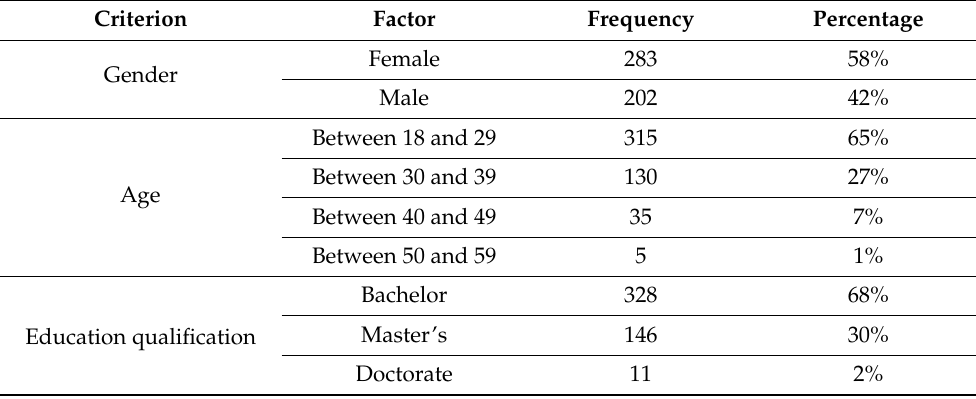
Table 1. Demographic data of the